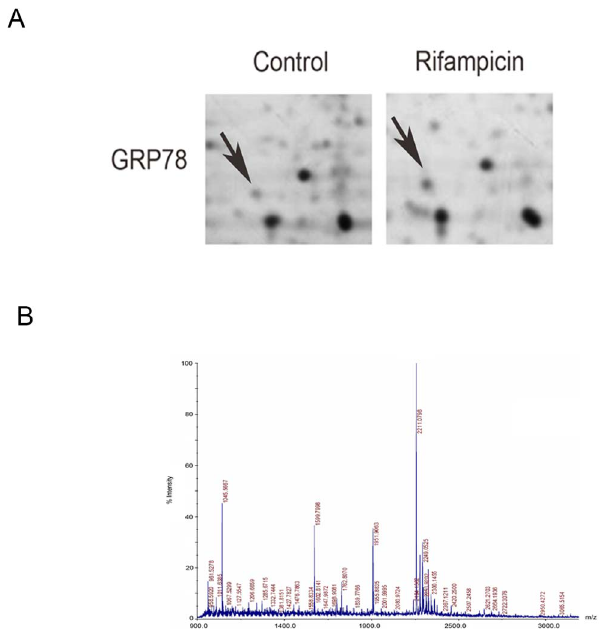
Figure 1. 2D-DIGE gel images of proteins isolated from rifampicin-treated PC12 cells. (A) Arrows indicate proteins that were differentially expressed in PC12 cells treated with or without rifampicin. (B) Representative peptide mass fingerprint spectra gener- ated by MALDI-TOF-MS. The x-axis indicates the mass-to-charge ratio, m/z. The y-axis indicates the relative abundance. Peptide masses are labeled and the corresponding m/z is annotated. rifampicin, which was not cytotoxic to PC12 cells (p . 0.05, Figure 3B).